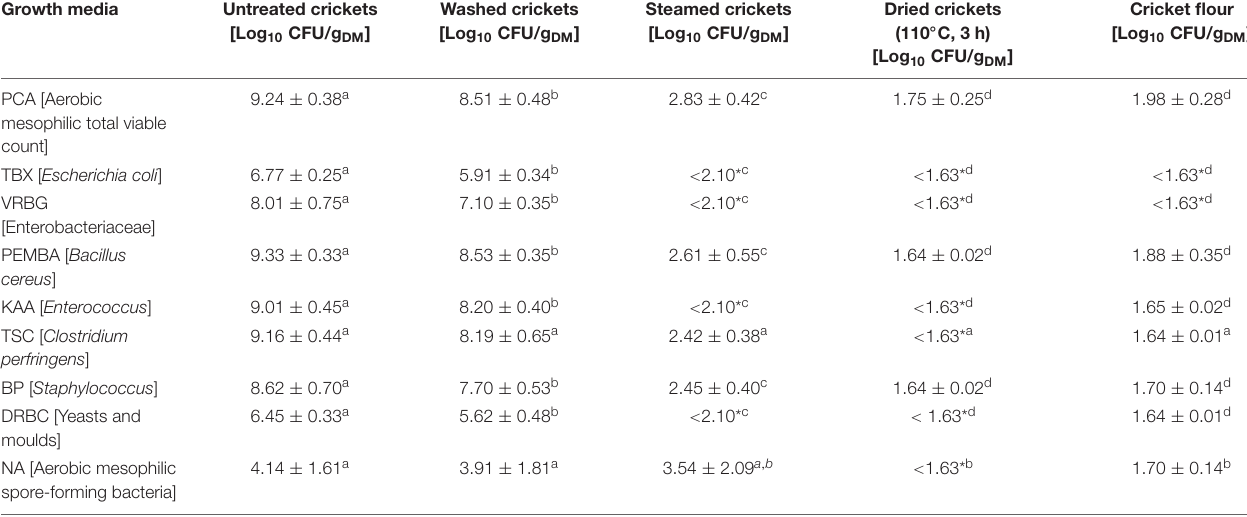
TABLE 4 | Total viable counts on non-selective and selective growth media along the processing chain of cricket flour.